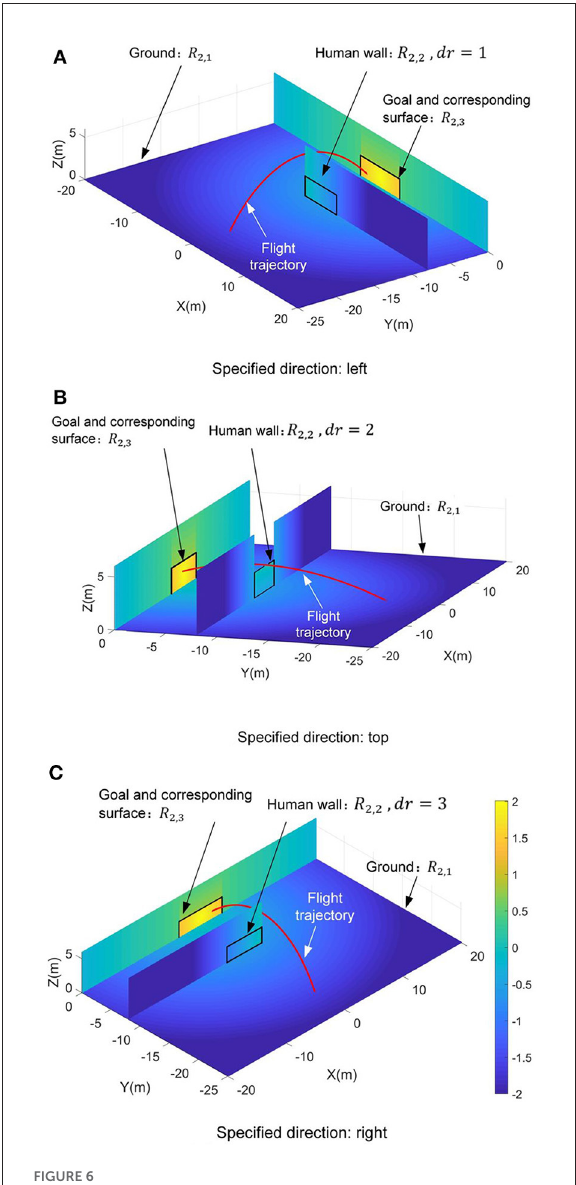
FIGURE6 Distributions of the value of the reward function R 2 on the sports field. (A) The specified direction dr = 1. (B) The specified direction dr = 2. (C) The specified direction dr =